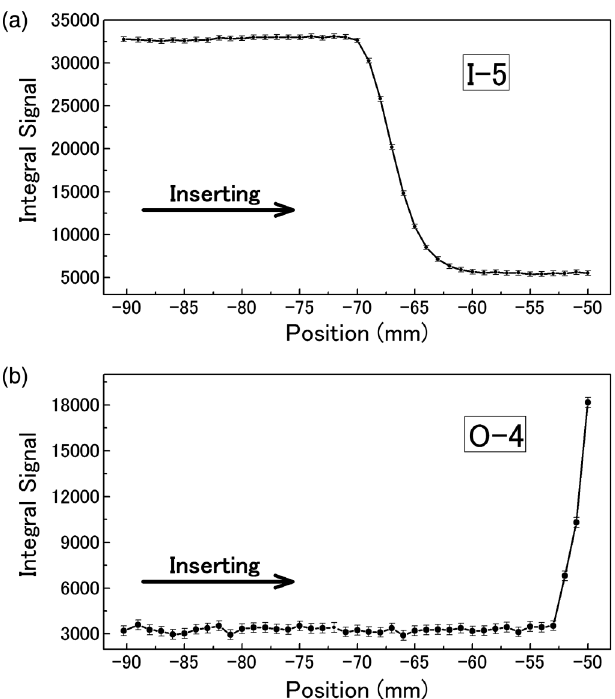
FIG. 11. Loss dependence on the insertion of the inside ab- sorber at (a) I-5 and (b) O-4. The horizontal axis corresponds to the position of the absorber. The vertical axis corresponds to (a) the loss caused by foil scattering, and (b) the loss caused by a halo of circulating beams.